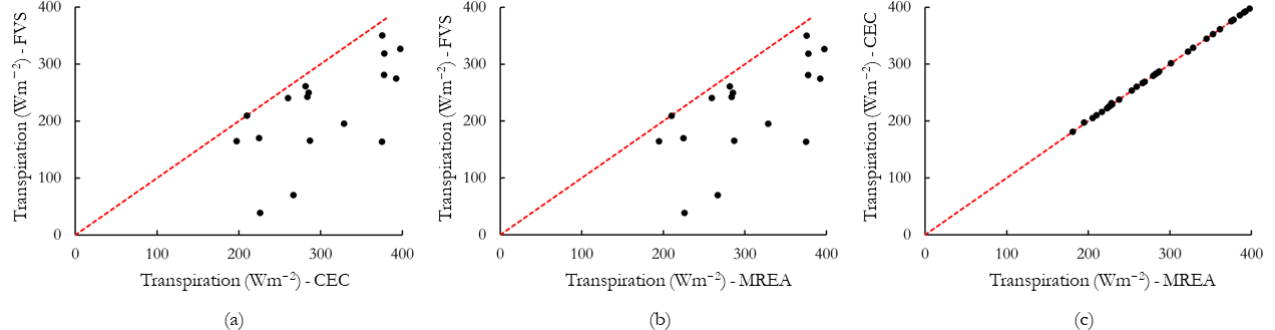
Figure 7. Scatter plots showing the difference between the transpiration estimated based on different methods (CEC, MREA, and FVS). The red dashline is a reference 1:1 line.